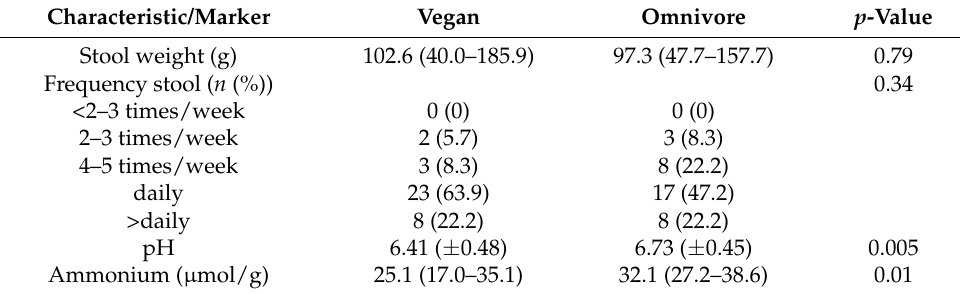
Table 2. Stool characteristics and fecal biomarkers in RBVD.